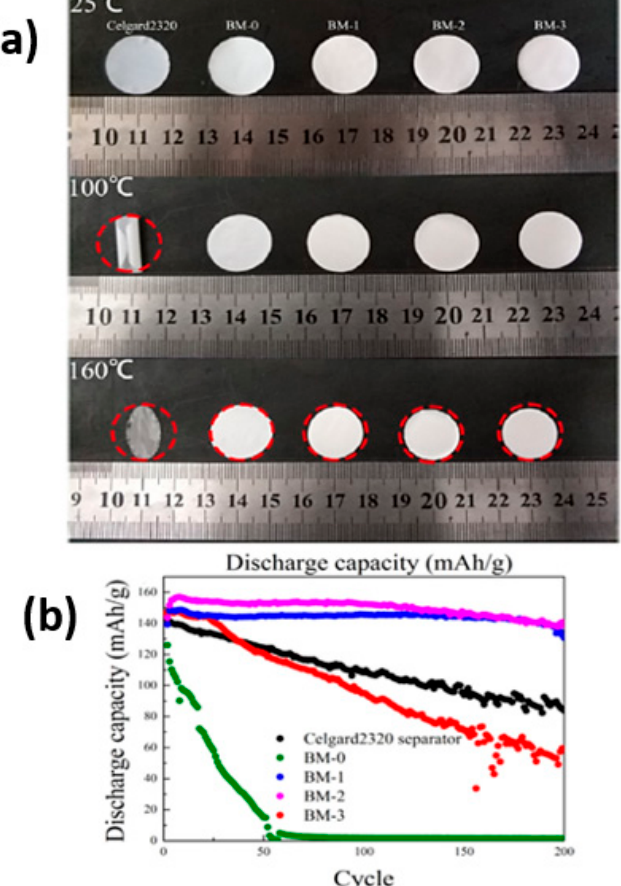
Figure 11. ( a ) Photographs of the membranes before and after heat treatment in an oven at 25 °C, 100 °C, and 160 °C. ( b ) The cycling stability of the cells at 1C [43]. Reprinted with permission by Elsevier from Blending-based polyacrylonitrile/poly (vinyl alcohol) membrane for rechargeable lithium ion batteries; C. He, J. Liu, J. Li, F. Zhu, and H. Zhao, J. Memb. Sci.; 560; © 2018.